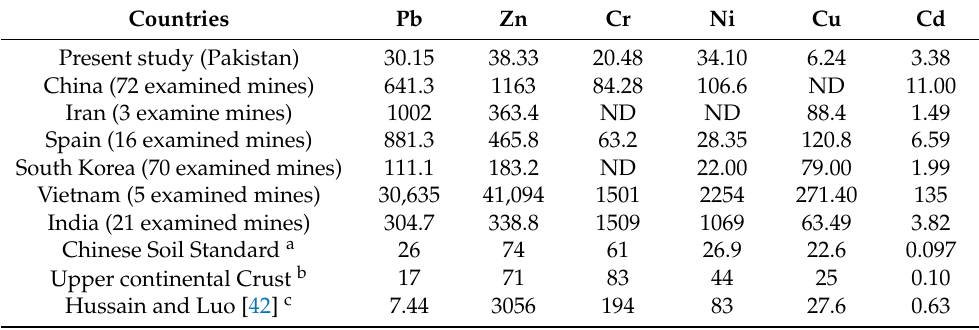
Table 2. Comparison of toxic trace elements (mg/kg) in coal waste contaminated elsewhere in the